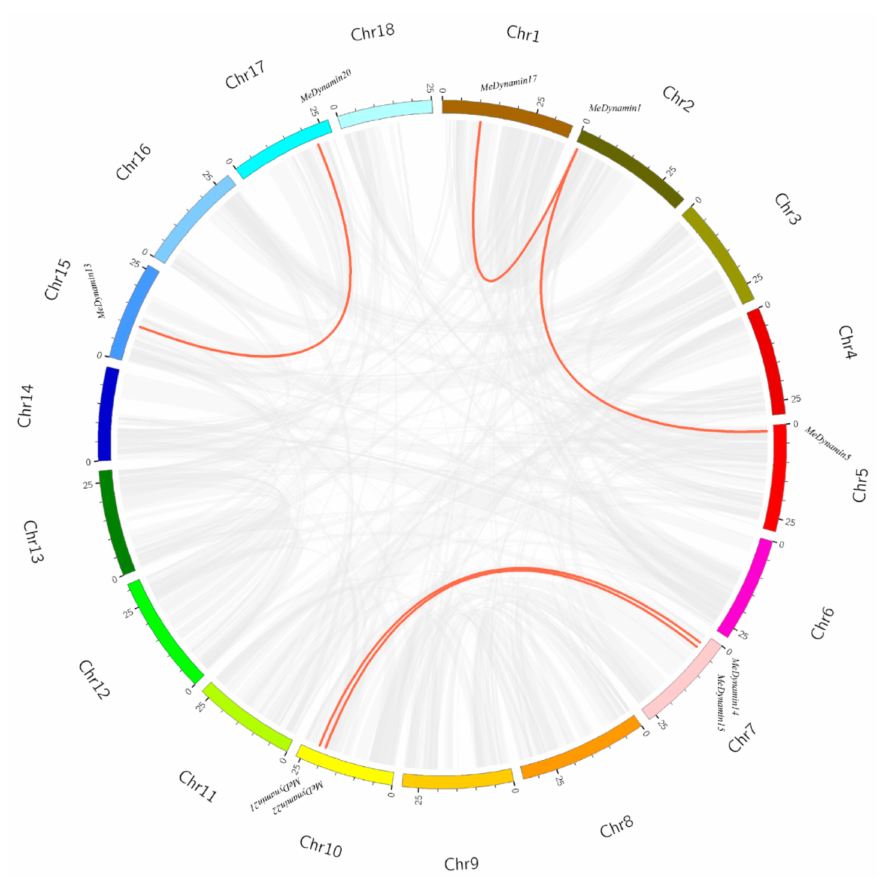
Figure 4. Schematic representations for the chromosomal distribution and interchromosomal relationships of MeDynamins . Gray lines indicate all synteny blocks in the cassava genome, and the red lines indicate duplicated Dynamin gene pairs. The chromosome number is indicated at the bottom of each